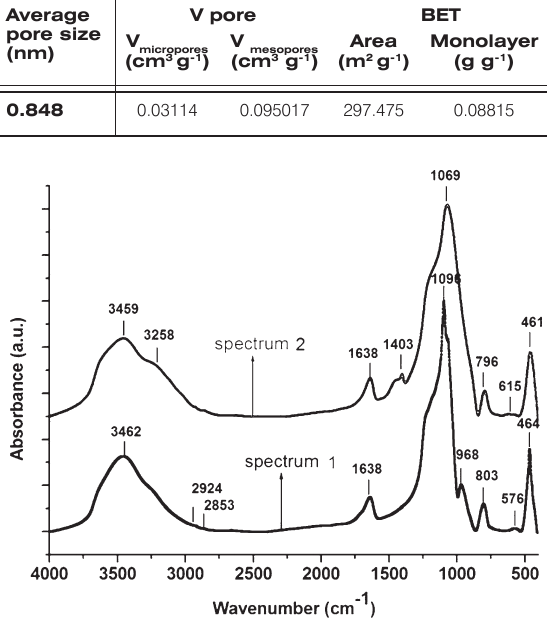
Table 1. Textural properties of catalyst beads determined from water sorption isotherm. Average pore size